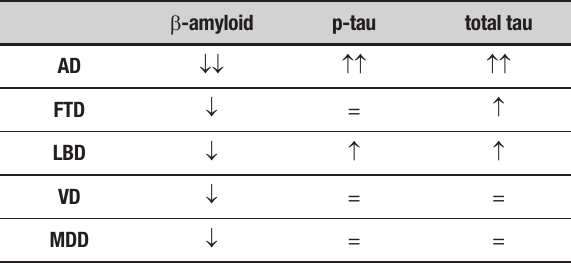
Table 1. Cerebrospinal fluid biomarkers in depressive disorders in the elderly, neurodegenerative disorders and psychiatric disorders.